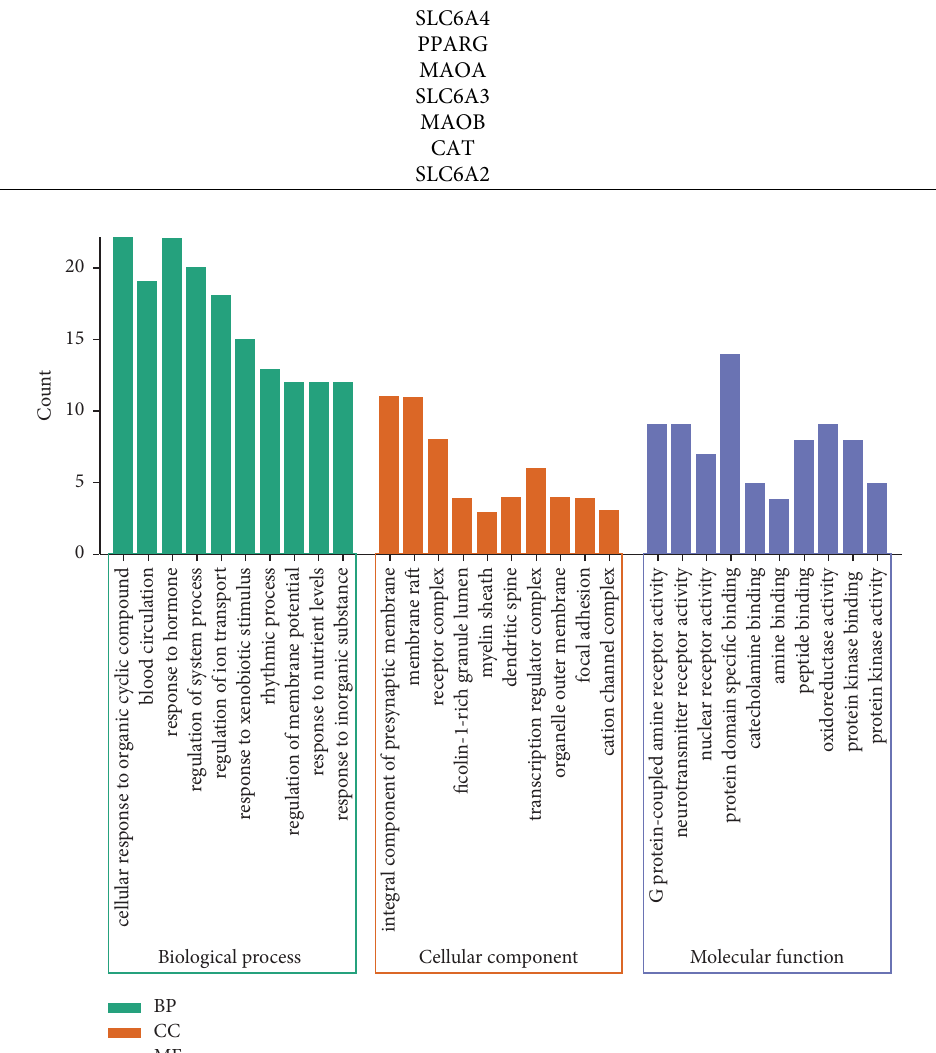
Figure 4: GO enrichment analysis graph.